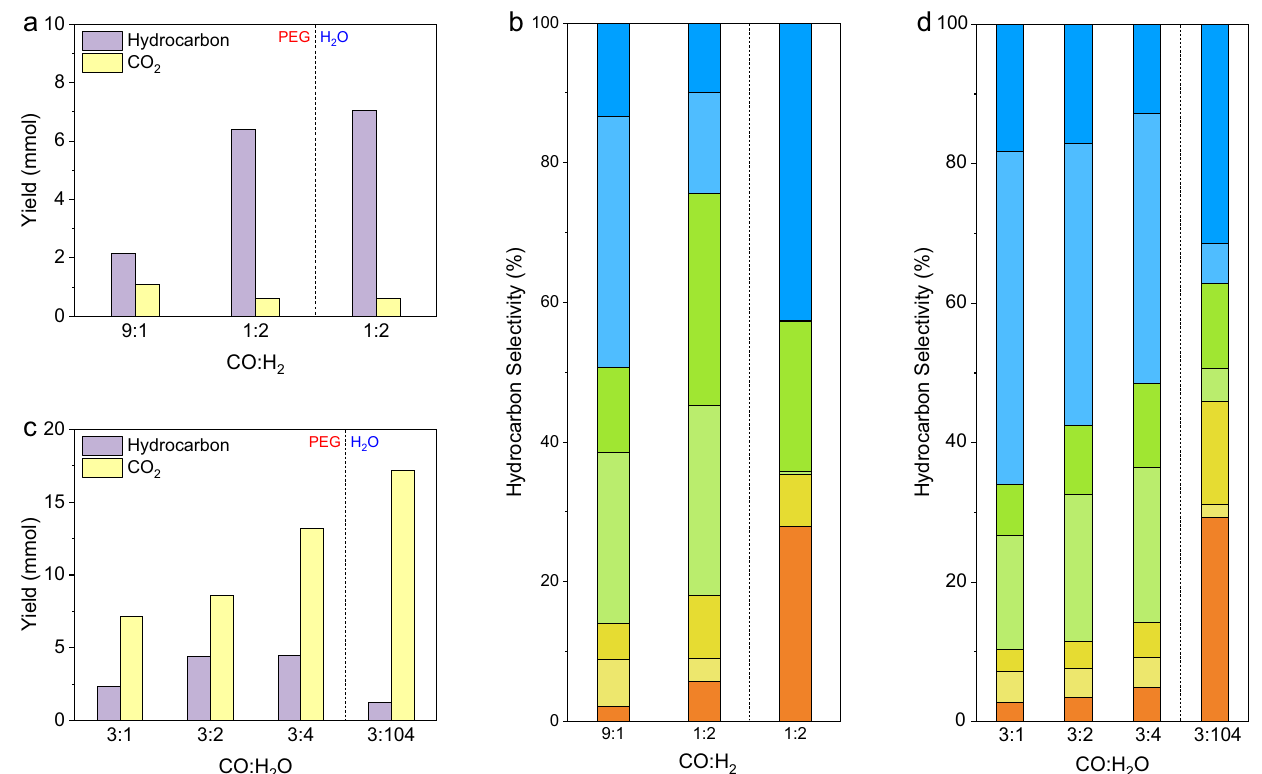
Fig. 4 | Mechanistic studies on KES. a , b FTS Catalytic performances for different ratios. a YieldsofhydrocarbonsandCO 2 onacarbon-atombasis.Fromlefttoright: CO/H 2 =9:1 in PEG, CO/H 2 =1:2 in PEG, and CO/H 2 =1:2 in water. b Fractional hydrocarbon selectivity. From left to right: CO/H 2 =9:1 in PEG, CO/H 2 =1:2 in PEG, and CO/H 2 =1:2 in water. All catalytic experiments were conducted in a 50-mL Hastelloyslurry reactor over Ru particles at 200°Cunder 2MPaof syngas for 10h. Volume of solvent (pure water or PEG) was kept to 15mL. c , d Impact of water on KES catalytic performances. c Yields of hydrocarbons and CO 2 on a